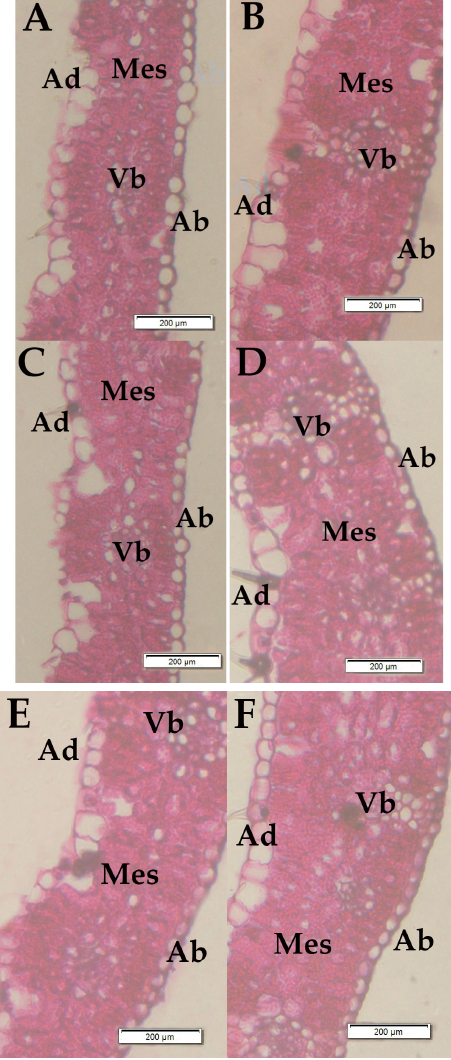
Fig. 2: Photographs of wheat leaf section as affected by salicylic acid or proline application grown under normal and field deficit irrigation conditions. A) I 60 ; B) I 100 ; C) SA + I 60 ; D) SA + I 100 ; E) proline + I 60 ; F) proline + I 100 Ab, abaxial surface; Ad, adaxial surface; Mes, mesophyll cells and vb, vascular bundle, scale bars=200 μm.